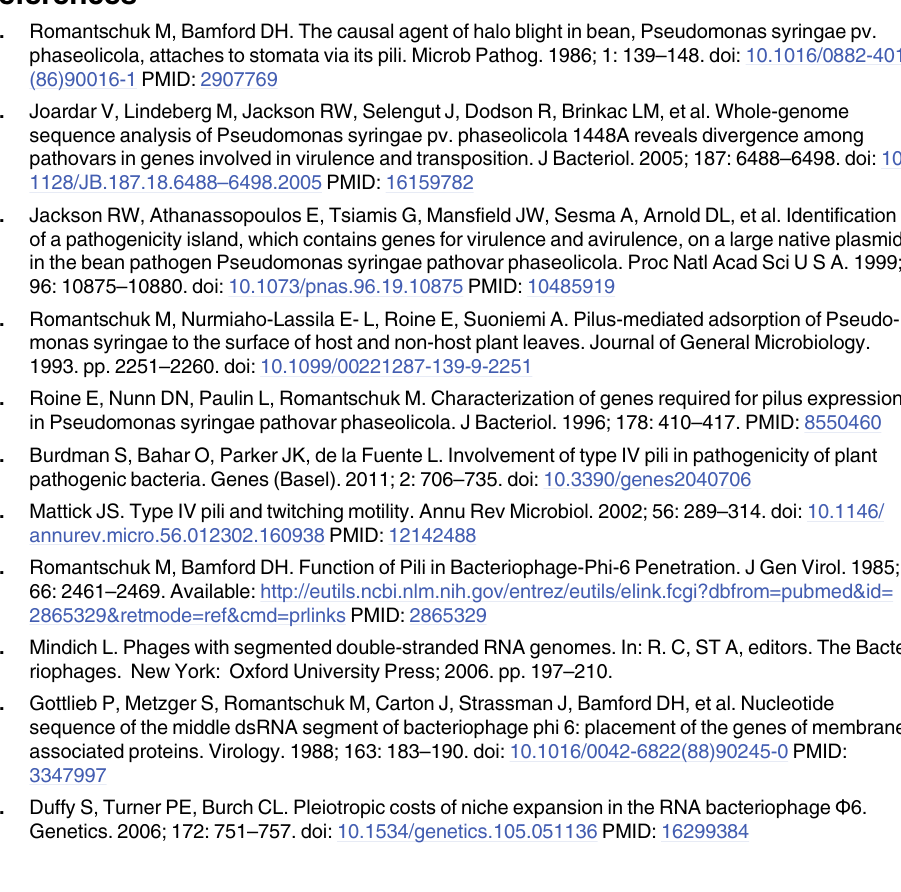
S1 Table. Genomic mutations present in super-piliated Pph in comparison to WT. S2 Table. Genomic mutations present in non-piliated Pph in comparison to WT. S3 Table. Gene expression differences between super and non-piliated Pph in comparison to WT. The number 1 indicates genes which are significantly up or down regulated, 0 indicates genes which do not show a significant